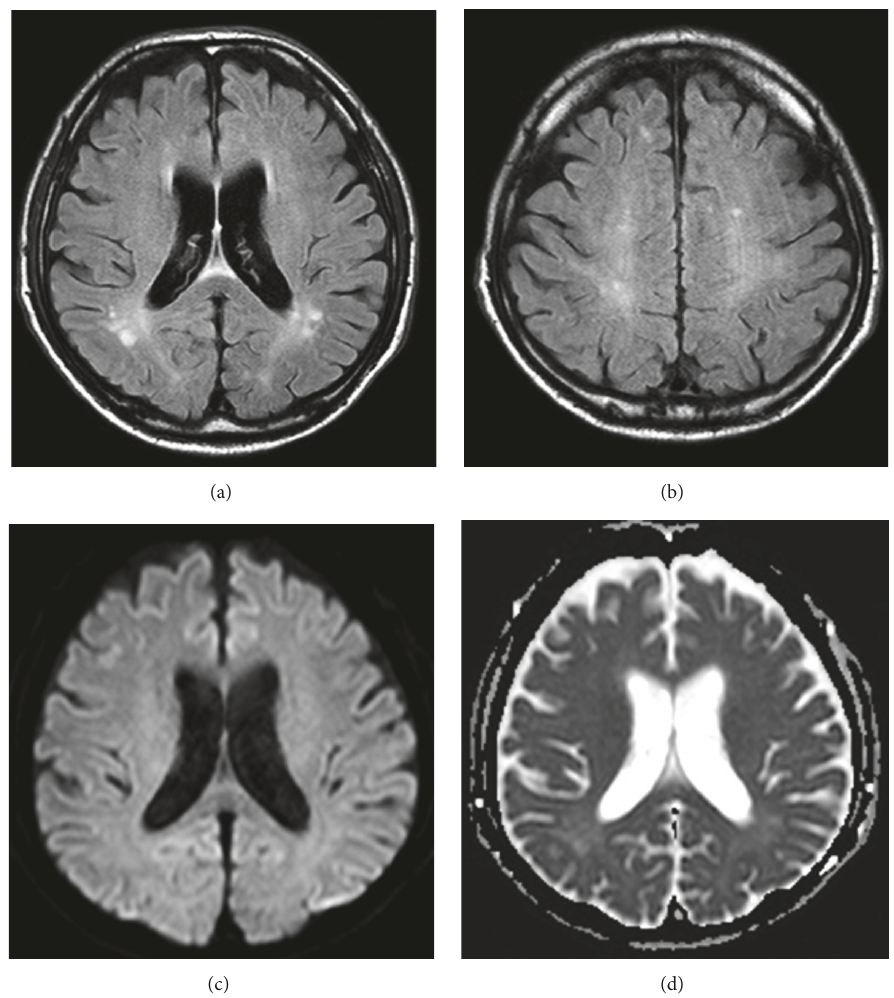
Figure 5: Brain MRI taken on day 29. ((a), (b)) Cranial T2-weighted FLAIR MRI showing several old small brain infarctions. (c) DWI obtained on day 29, showing no hyperintense signal alterations. (d) ADC mapping obtained on day 29, showing no increased diffusion in cerebral